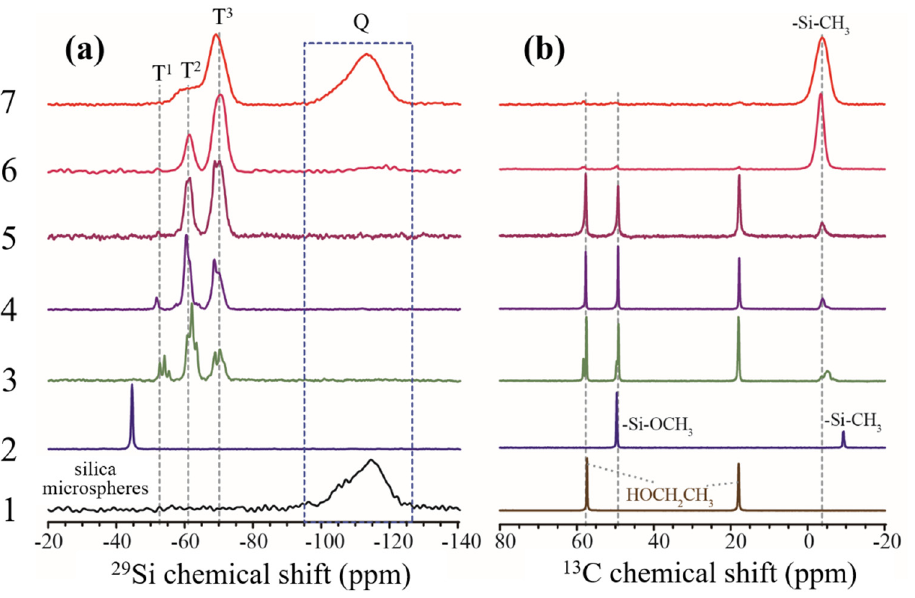
Figure 2. High-resolution 29 Si NMR ( a ) and 13 C NMR ( b ) spectra for tracking the evolution of MTMS precursors and the formation of MSL. The label 1–7 denotes the precursor, solvent, or the products generated at each step of the sol-gel reaction: 1. silica microsphere ( a ) or ethanol ( b ); 2. methyltrimethoxysilane; 3. mixture A in Section 2.2; 4. mixture B in Section 2.2; 5. mixture C